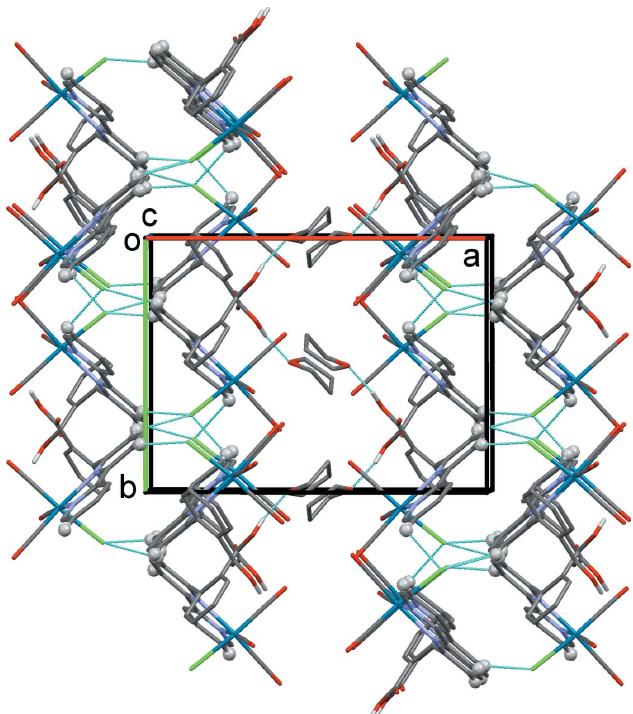
Figure 6 A view along the c axis of the crystal packing of compound II . The O— H (cid:2)(cid:2)(cid:2) O and C—H (cid:2)(cid:2)(cid:2) Cl hydrogen bonds are shown as dashed lines (Table 2). Only the major component of the disordered THF molecule is shown and H atoms not involved in these interactions have been omitted for